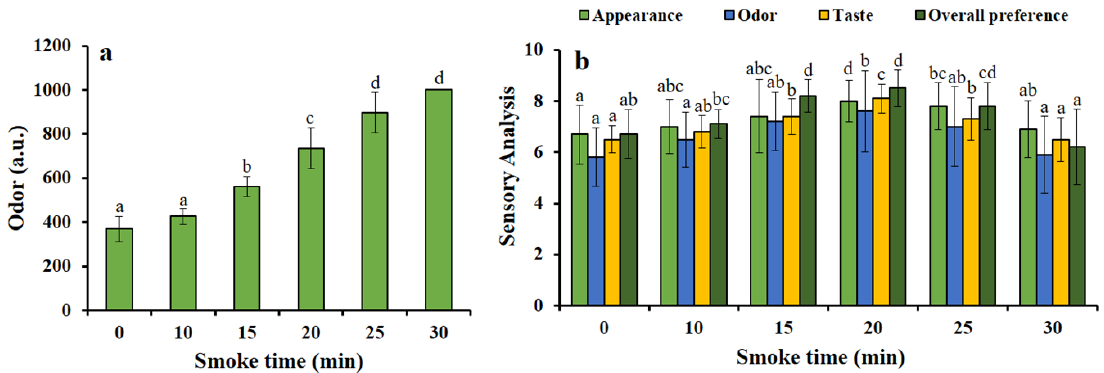
Figure 2. Different smoking times on the changes of ( a ) odor (a.u.) and ( b ) sensory quality attributes of hot smoked HDPS. Data represent the mean ± std of 10 observations, where groups not sharing a letter are expressed as significantly different ( p <